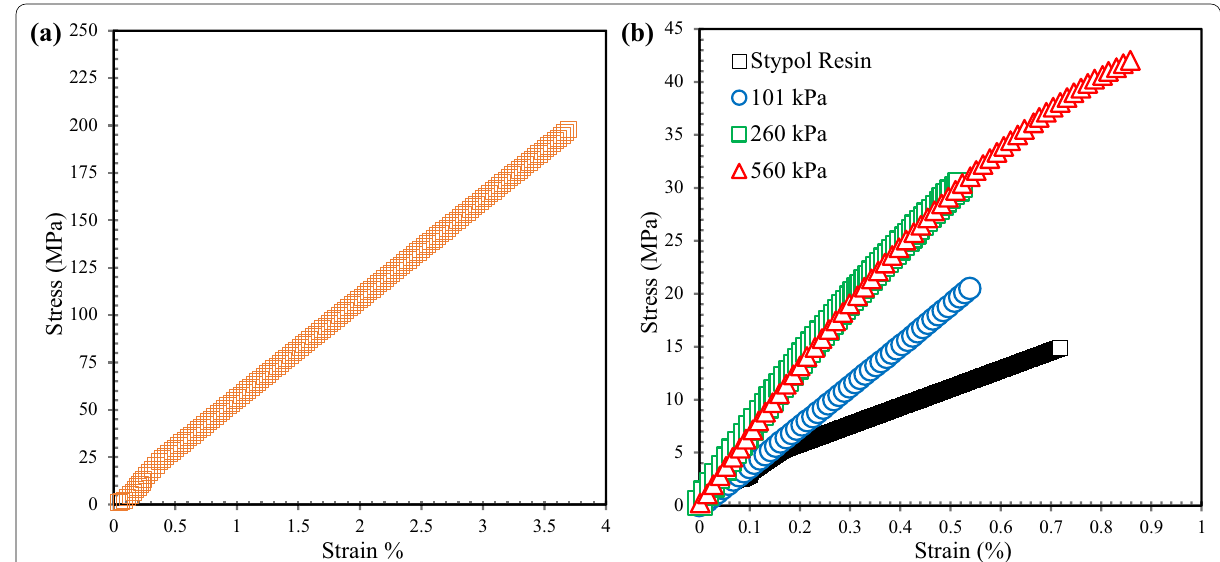
Fig. 8 Representative stress–strain curve for a cattail fiber and b Stypol resin and cattail mat composites manufactured at different pressures